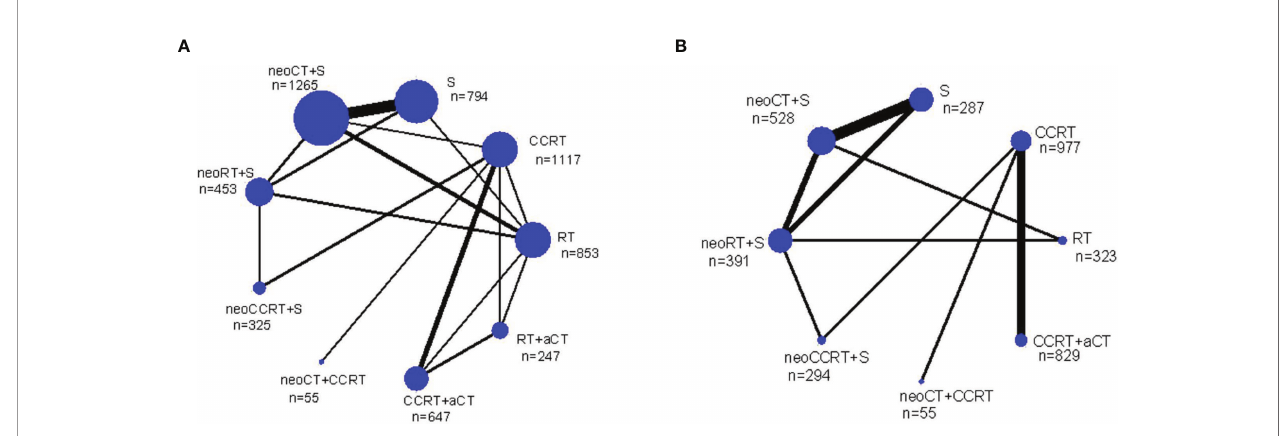
FIGURE 2 | Network diagrams of the overall survival (A) and progression free survival (B) for the multimodality treatments included in the analysis. Each link represents at least 1 study and the widths of each link are proportional to the number of studies comparing the particular arms. The size of each node is proportional to the total sample size. a, adjuvant; neo, neoadjuvant; n, number of patients; CCRT, chemoradiotherapy; CT, chemotherapy; RT, radiotherapy; S, surgery.